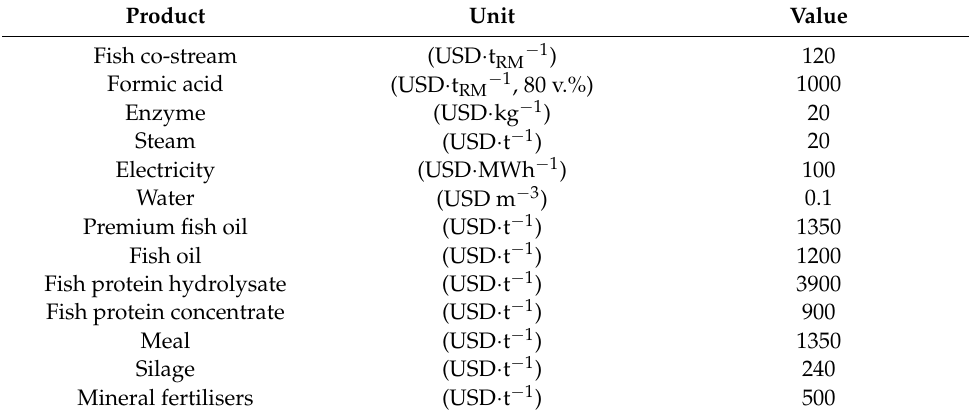
Table 4. Applied prices.